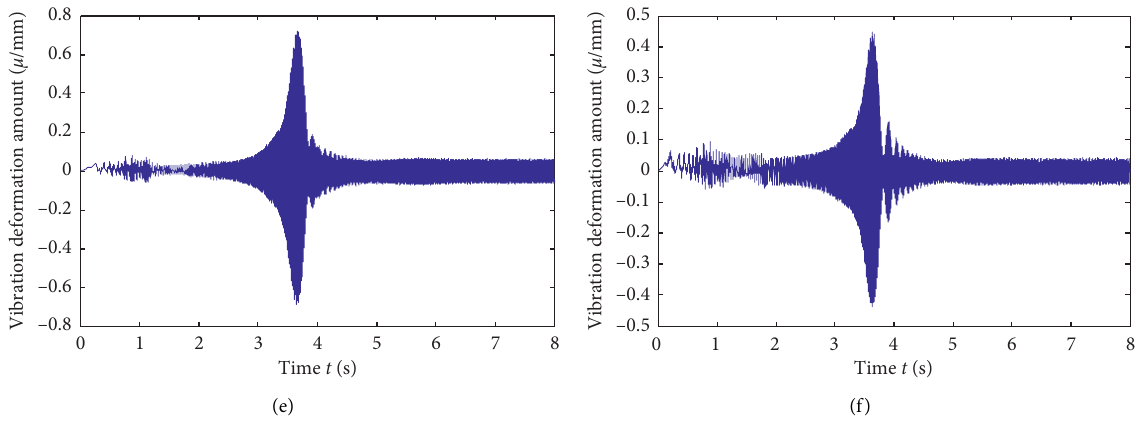
Figure 14: Effect of the interaction support I × II on the dynamic response of the shafting across the first-order critical speed. (a) Support position − 40mm, 40mm, 0mm. (b) Supports’ positions − 40mm, 0mm, 0 mm. (c) Supports’ positions − 40mm, 40mm, − 30mm. (d) Supports’ positions − 40mm, 0mm, − 30mm. (e) Support’s positions − 40mm, 40 mm, − 60mm. (f) Supports’ positions − 40 mm, 0mm, − 60mm.